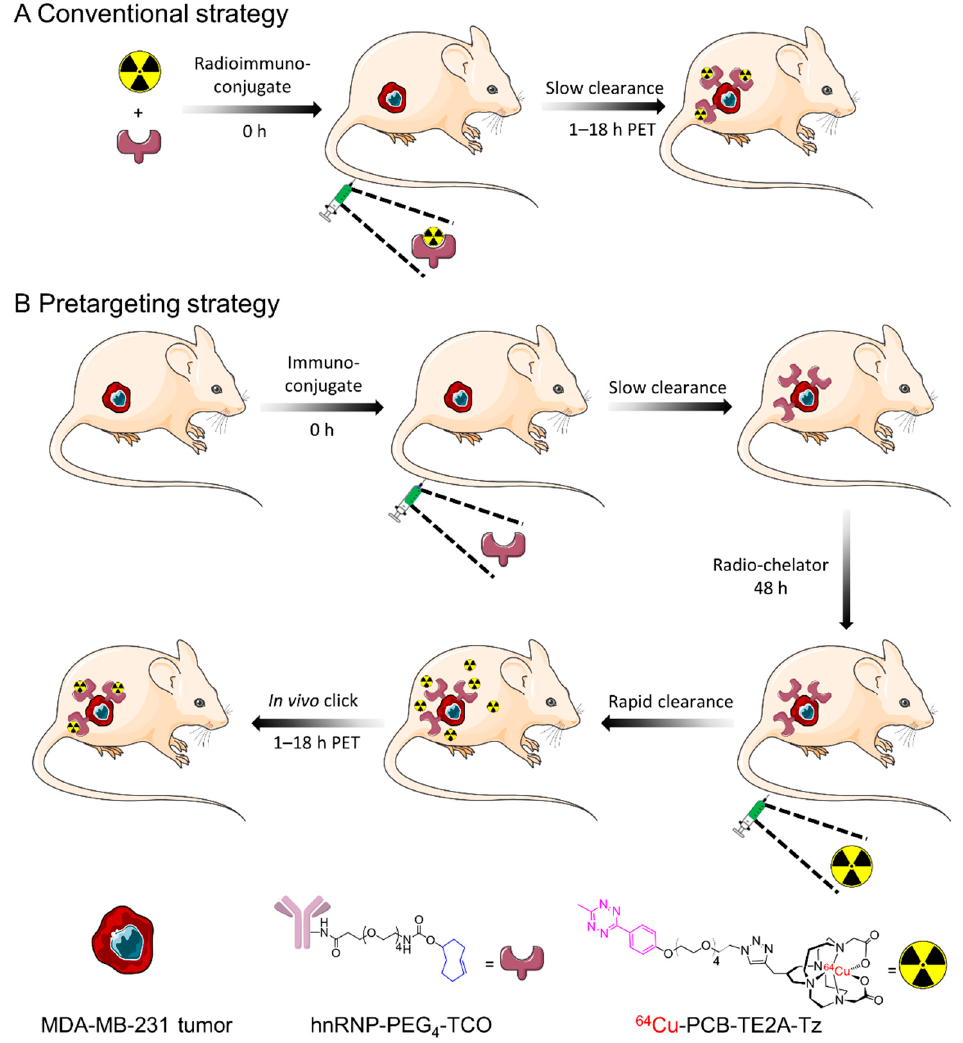
Figure 1. Schematic illustration depicting the ( A ) conventional strategy and ( B ) steps involved in pretargeting strategy using tetrazine (Tz)-trans-cyclooctene (TCO) reactive groups for bioorthogonal click reaction.